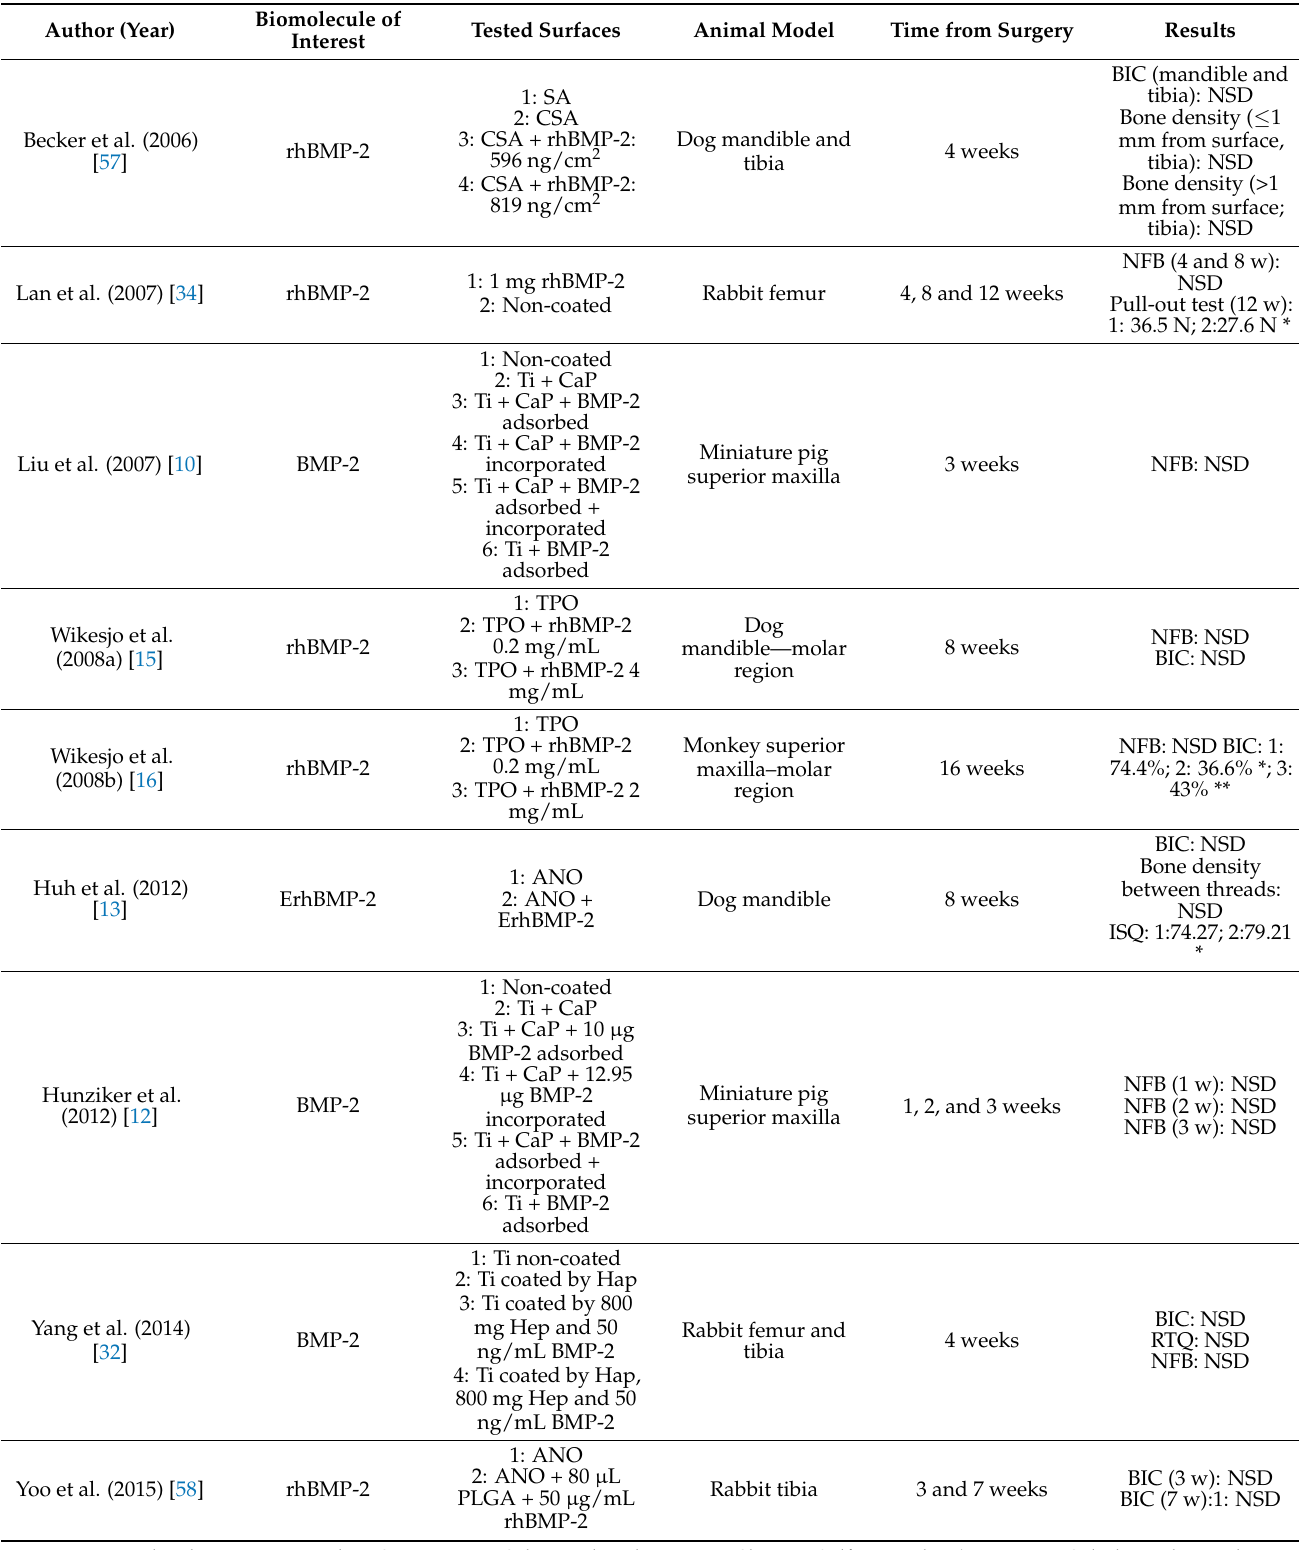
Table 3. BMPs: results from the considered